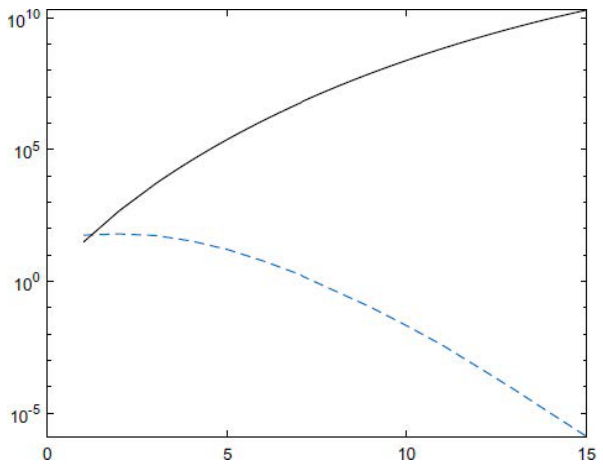
Fig. 3 Maclaurin series expansion coefficient of binomial power